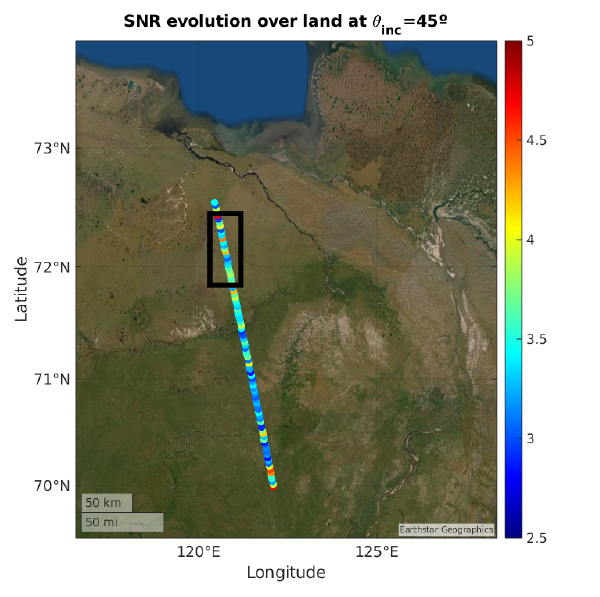
Figure 17. SNR evolution (dB) for a selected track at the North of Russia, collected on the 12 Octo- ber 2020.